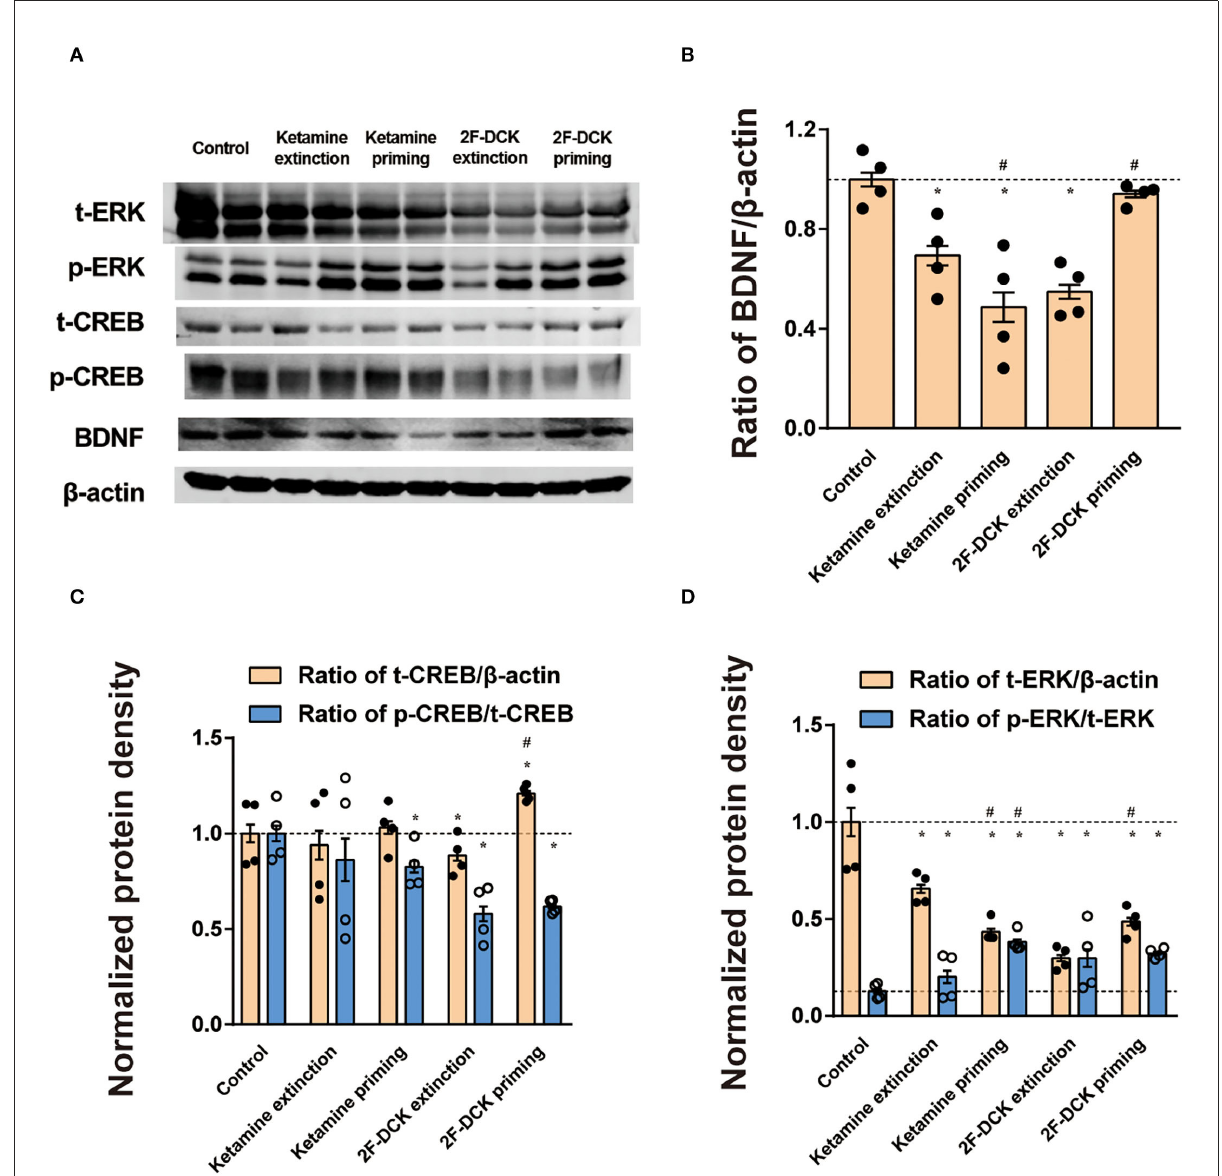
FIGURE4 Expression of BDNF, CREB, ERK, CREB, and ERK phosphorylation in the NAc during extinction and reinstatement. (A) Representative bands of BDNF, CREB, and CREB phosphorylation and β -actin in the NAc, and quantification of Western blot bands, with each bar representing the mean ± SEM ( n = 4). (B) The histogram shows the relative expression of BDNF to β -actin among the groups. (C) The histogram shows the relative expression of t-CREB/ β -actin and p-CREB/t-CREB. (D) The histogram is shown as the relative expression of t-ERK/ β -actin and p-ERK/t-ERK. * P < 0.05 in comparison with the control and # P < 0.05 in comparison with